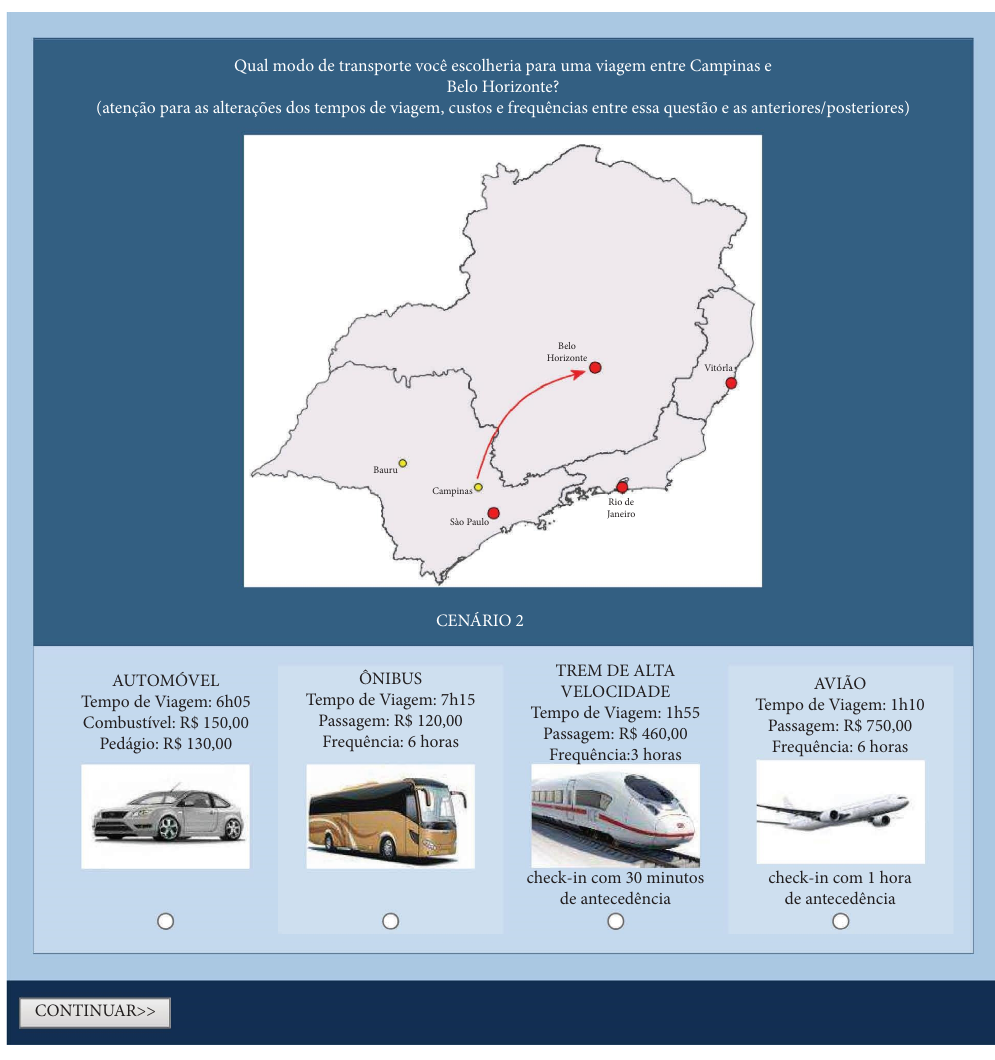
Figure 6: Example of choice